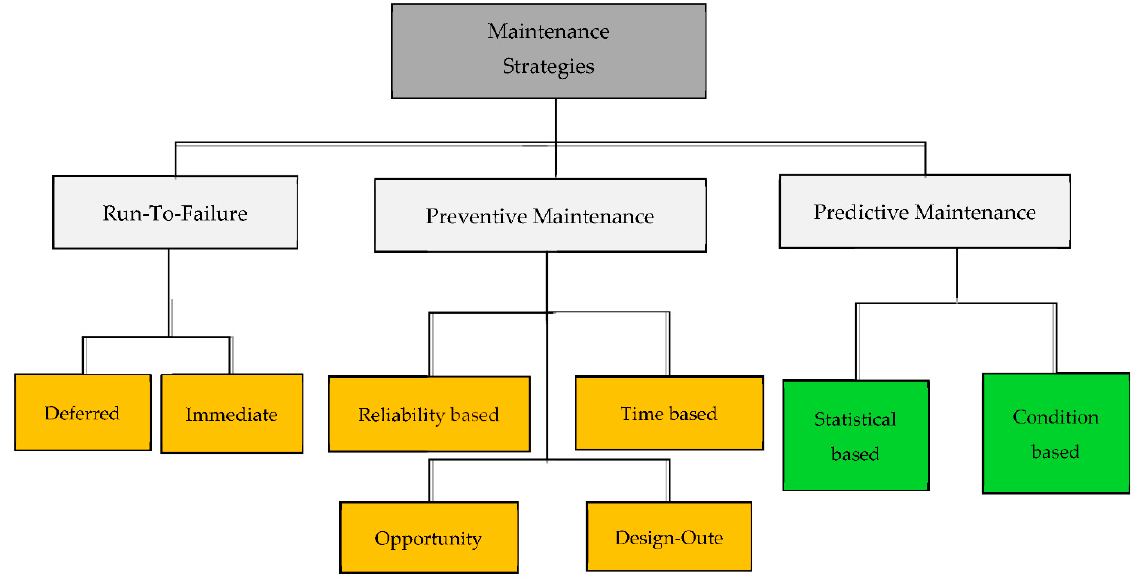
Figure 1. Classifications of maintenance strategies [5].